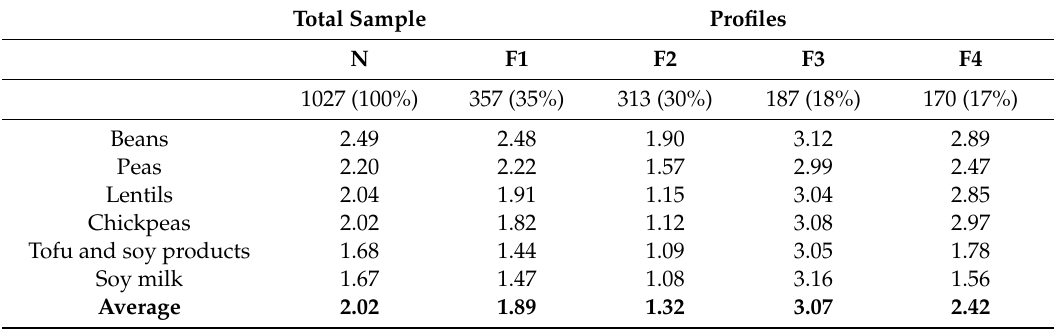
Table 2. Frequency of eating pulses and soy products in the total sample and 4